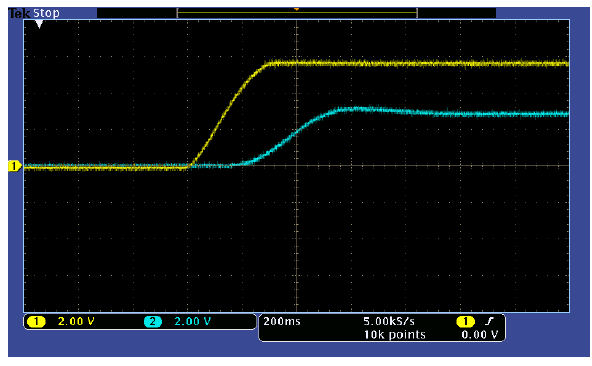
Figure 15. Fractional (50%)